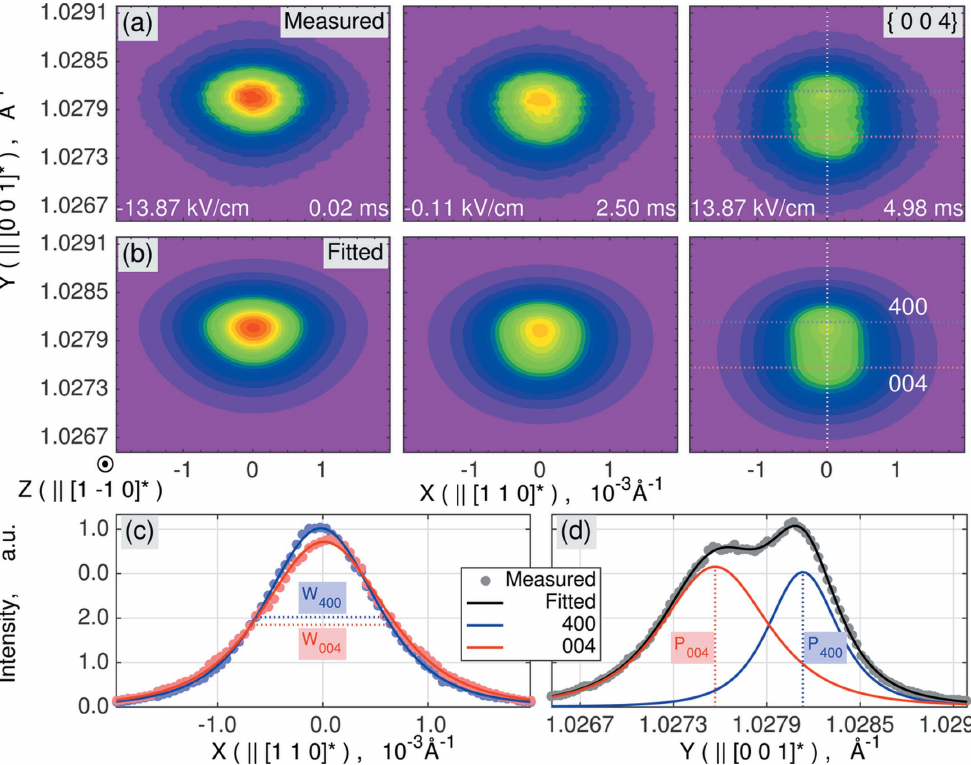
Figure 3 Measured and fitted X-ray scattering intensity distributions around {004} reflections in the reciprocal lattice coordinates X || [110]* and Y || [001]*. ( a ) Measured RSMs and ( b ) their fit by the superposition of a pair of two-dimensional Moffat distribution functions. ( c ) and ( d ) X and Y intensity profiles of 400 (higher) and 004 (lower) Bragg-peak components at 13.87 kV cm (cid:3) 1 of electric field. An animated version of panels ( a ) and ( b ) is available in the supporting